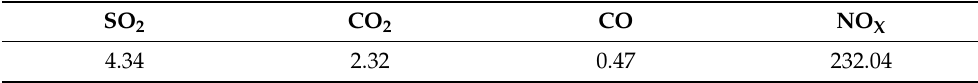
Table A1. Diesel generator pollutant emission factor (g/kWh).